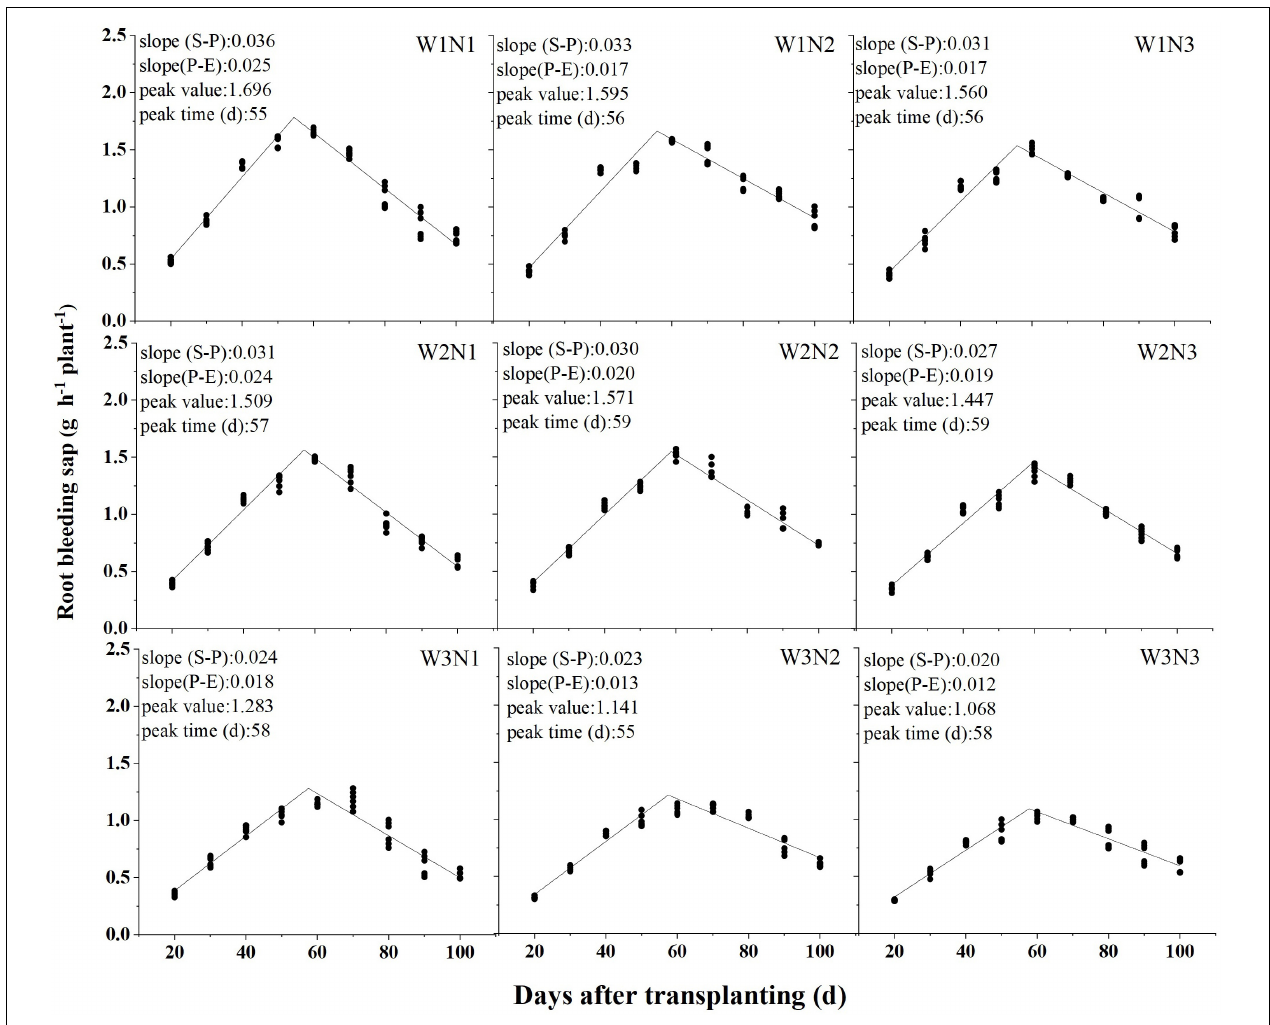
FIGURE 2 | Effect of the irrigation methods and N split application on root bleeding sap. Shown are the means values ( N = 6). The linear regressions were analyzed by pooling out data for 2 years. Numbers on the top are slope of the starting point to the peak slope (S-P). Numbers on the middle are absolute value slope of the peak to the ending point of the line slope (P-E). Numbers on the bottom are the time of piecewise